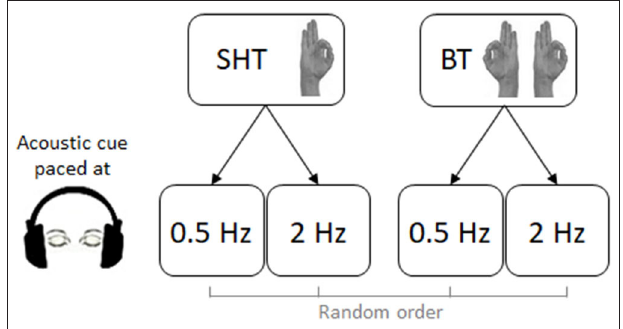
FIGURE 1 | Experimental paradigm. Subjects were required to perform a finger-opposition movement sequence (opposition of the thumb to the index, medium, ring, and little fingers) in synchrony with a metronome at 0.5 and 2Hz, with the right hand only (single hand task—SHT) or with both hands (bimanual task—BT), for a total duration of 45s. The four experimental conditions were executed in a random order.